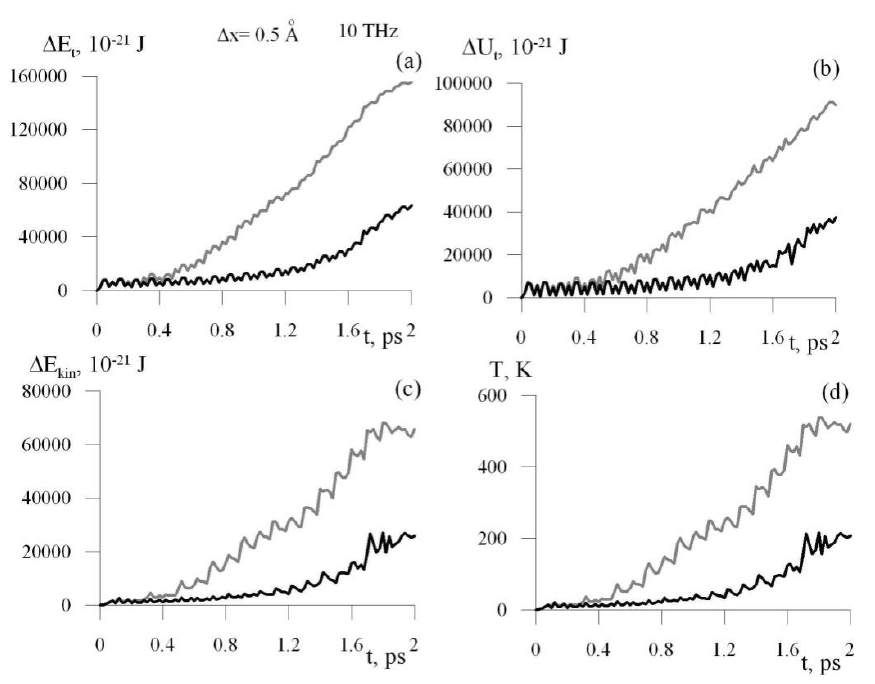
Fig. 24. Amplification of the total energy (а) and its components: potential (b) and kinetic (c), system temperature (d) versus time. Black line – perfect crystal, grey line – amorphized system.  x 0 = 0.5 Å,  =10 THz.